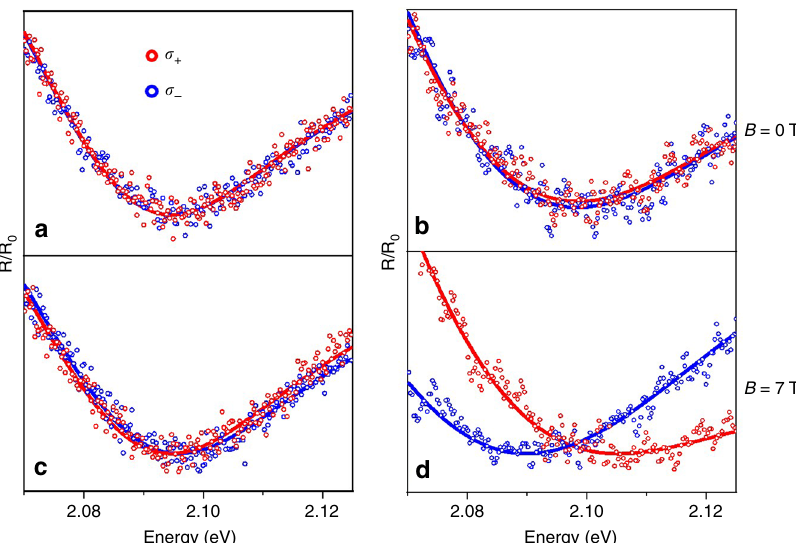
Fig. 2 Magneto-re fl ectance spectra of monolayer WS 2 . Re fl ectance spectra of monolayer WS 2 on Si/SiO 2 substrate at T = 7 K, B = 0 T ( a ) and 7 T ( c ); and on EuS substrate at B = 0 T ( b ) and 7 T ( d ). The magnetic fi eld is perpendicular to the plane of the sample